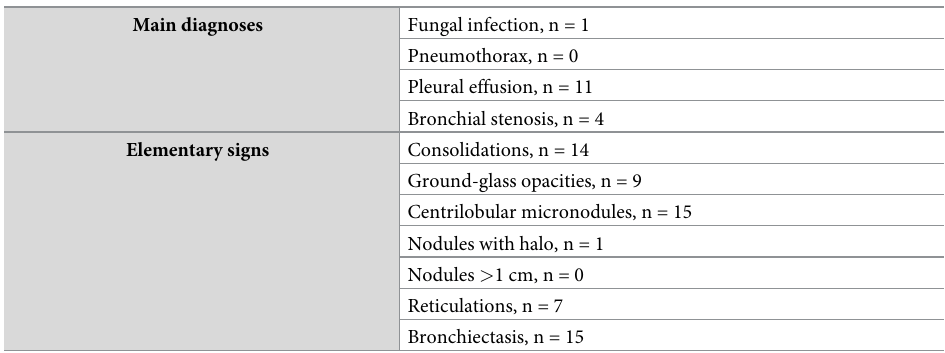
Table 4. Main diagnoses and elementary